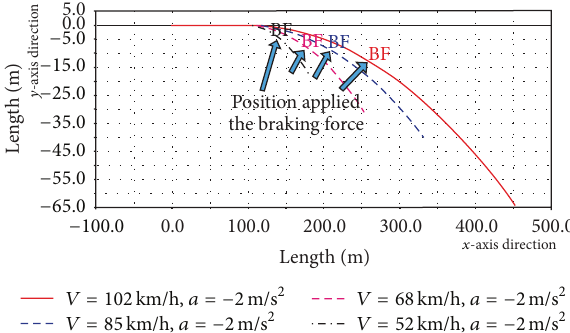
Figure 7: Vehicle trajectory with a braking deceleration of 2m/s 2 .